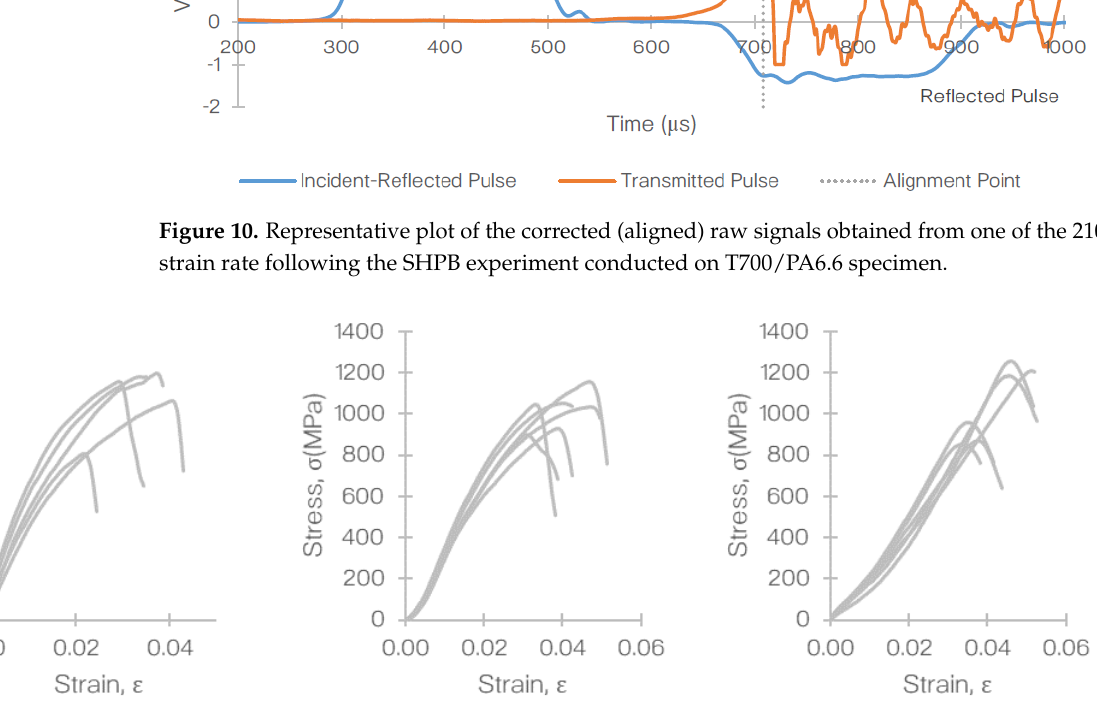
Figure 11. Stress–strain plots obtained from the SHPB tensile test of T700/PA6.6 at different strain rates: ( a ) 700, ( b ) 1400, and ( c ) 2100/s. Table 4. Summary of the dynamic tensile properties obtained from the SHPB experiment of the T700/PA6.6.